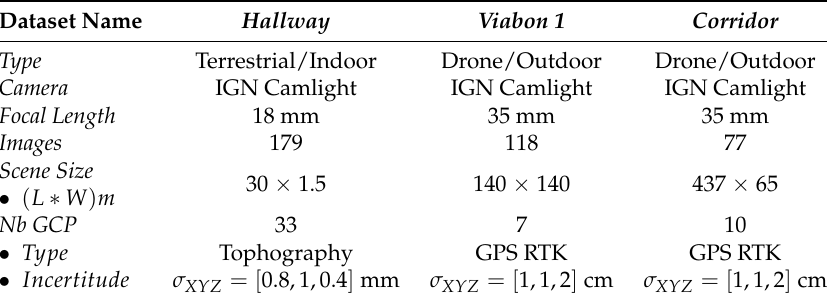
Table 1. Description of four datasets used to evaluate the